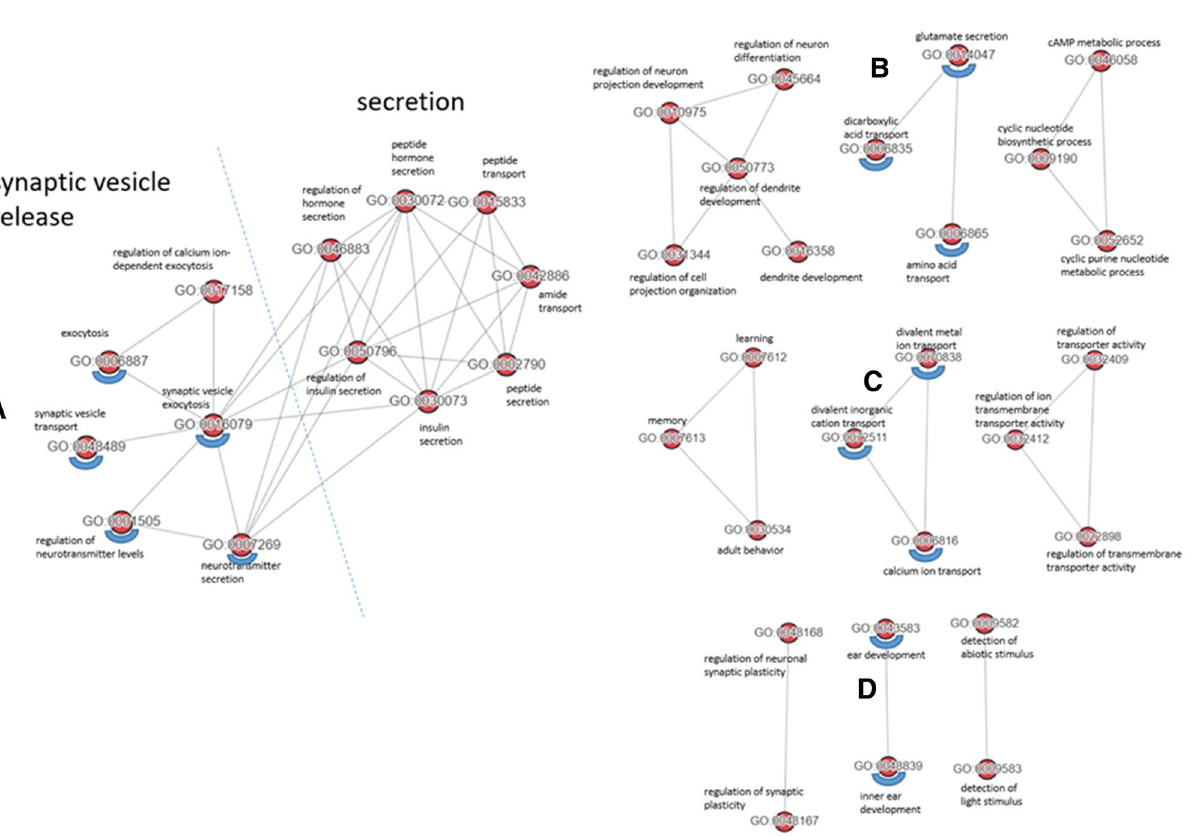
Figure 3. Unique meaningful GO clusters specific for AD brain. The GO terms underlined with blue semicircles were found in each